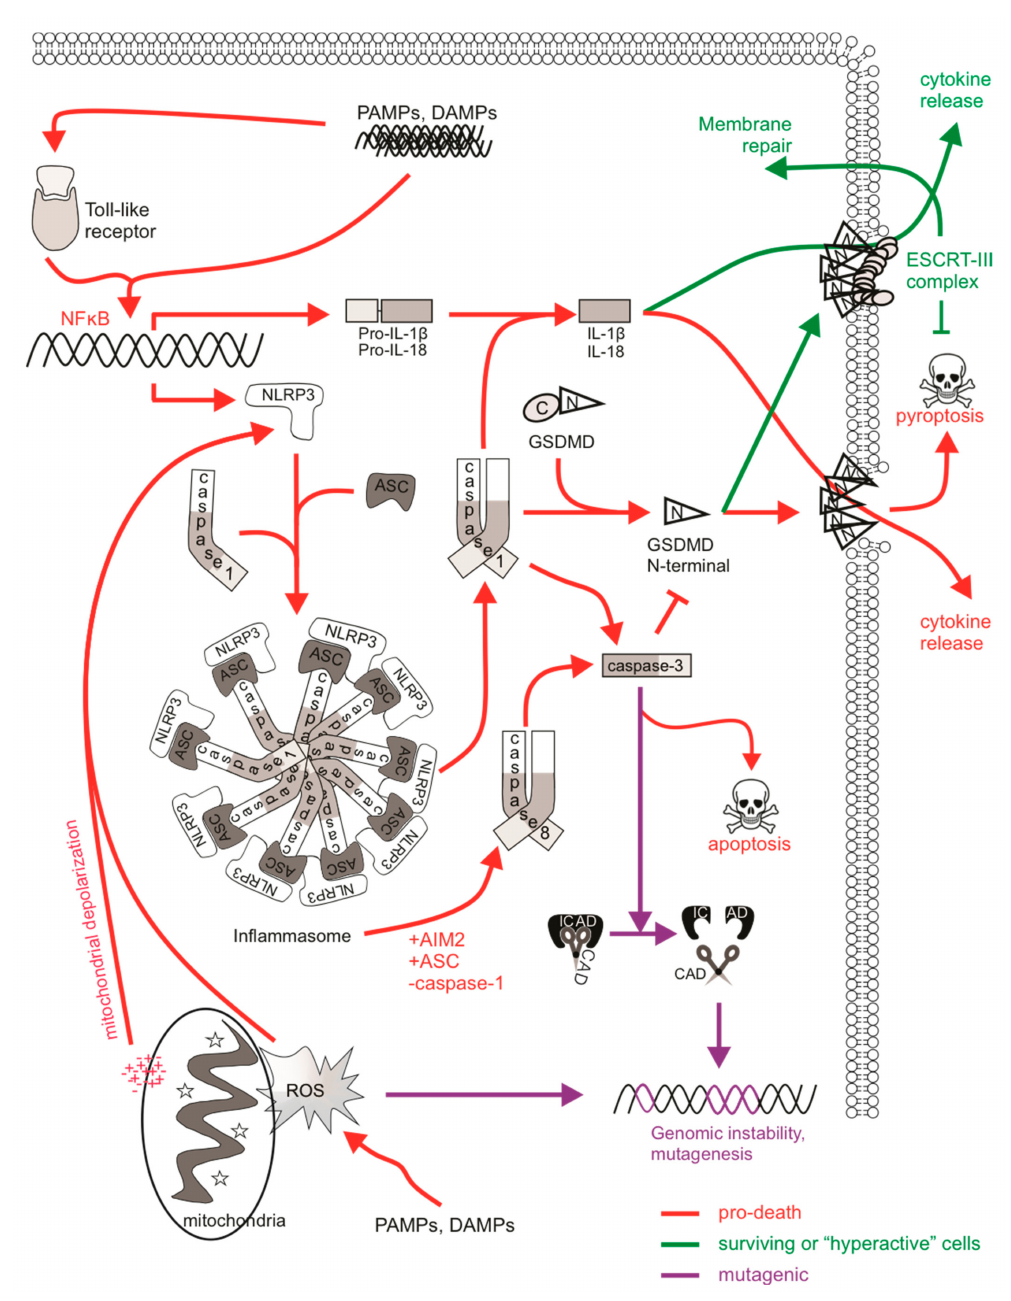
Figure 3. The mutagenic potential of pyroptotic signaling. PAMPs/DAMPs can directly or indirectly stimulate inflamma- some formation via NF κ B-mediated transcription. Sensing (e.g., NLRP3 or AIM2) and adaptor (e.g., ASC) proteins